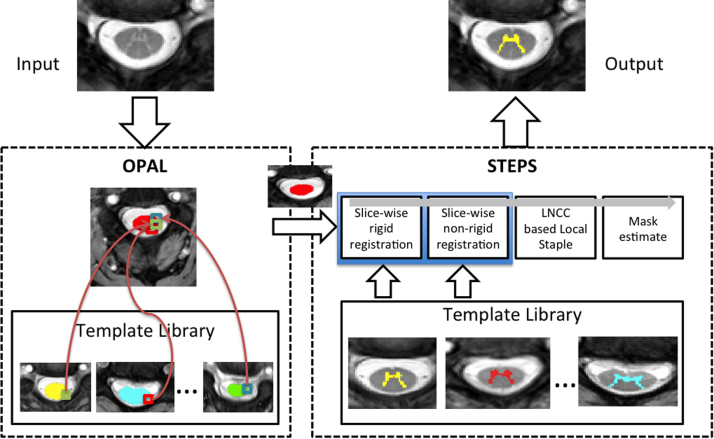
Schematic representation of the proposed pipeline.